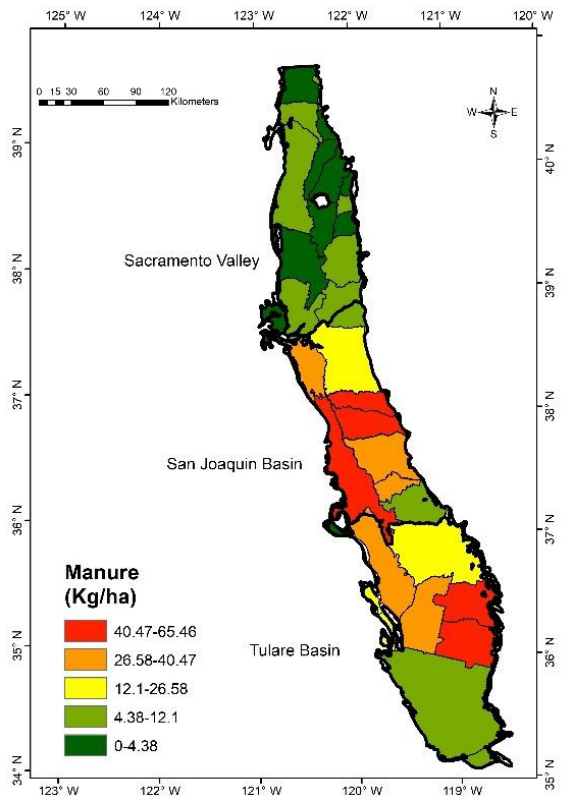
Figure 14. Manure Loading in Central Valley. ISPRS Int. J. Geo-Inf. 2018 , 7 , x FOR PEER REVIEW